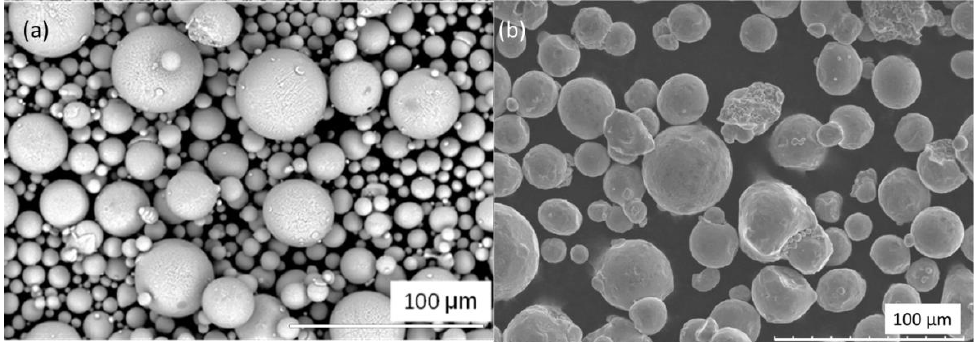
Figure 9. Captured micrographs of ( a ) backscatter detection from Powder A and ( b ) secondary electron detection from Powder B, both images were taken at 20.0 kV.